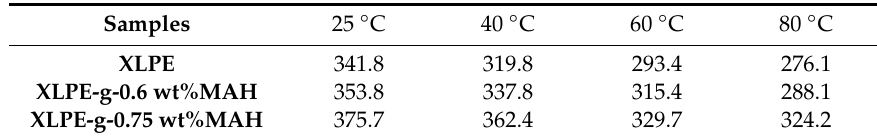
Figure 6. Dielectric breakdown strength (DBS) statistics fitted with two-parameter Weibull distribution for XLPE and XLPE-g-MAH at the temperatures of 25 ‒ 80 °C. Table 3. The characteristic 63.2% DBS of Weibull distribution fitted in a 95% confidence interval at different temperatures (kV/mm).